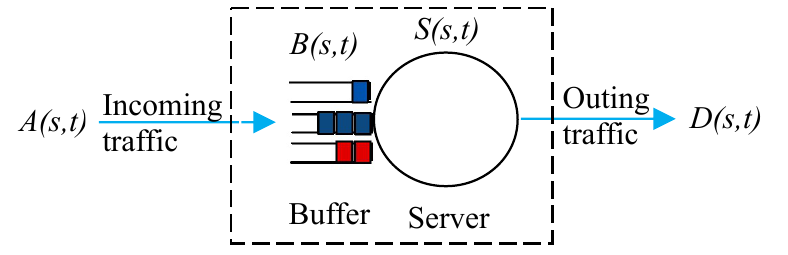
Figure 1. Queuing model of a store forward